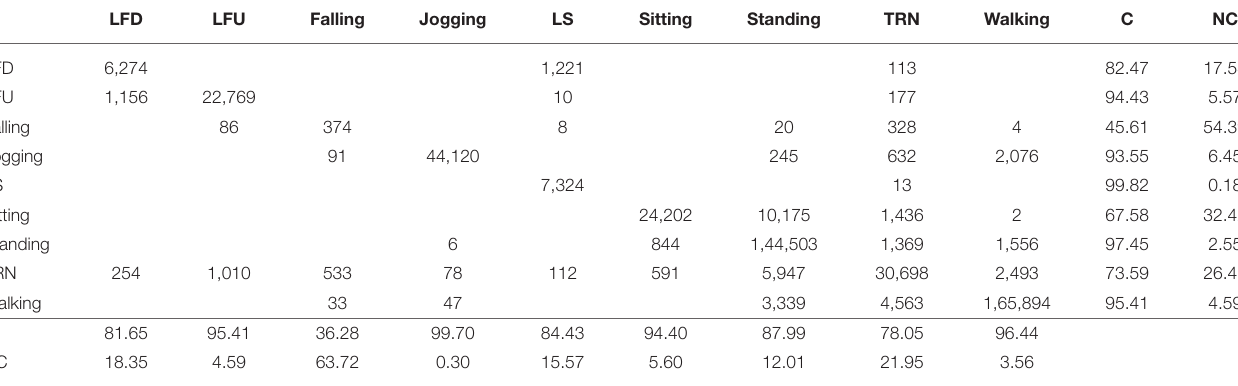
TABLE 6 | Confusion matrix using Bagging and Decision Tree using both ear-level accelerometers, and the waist accelerometer.